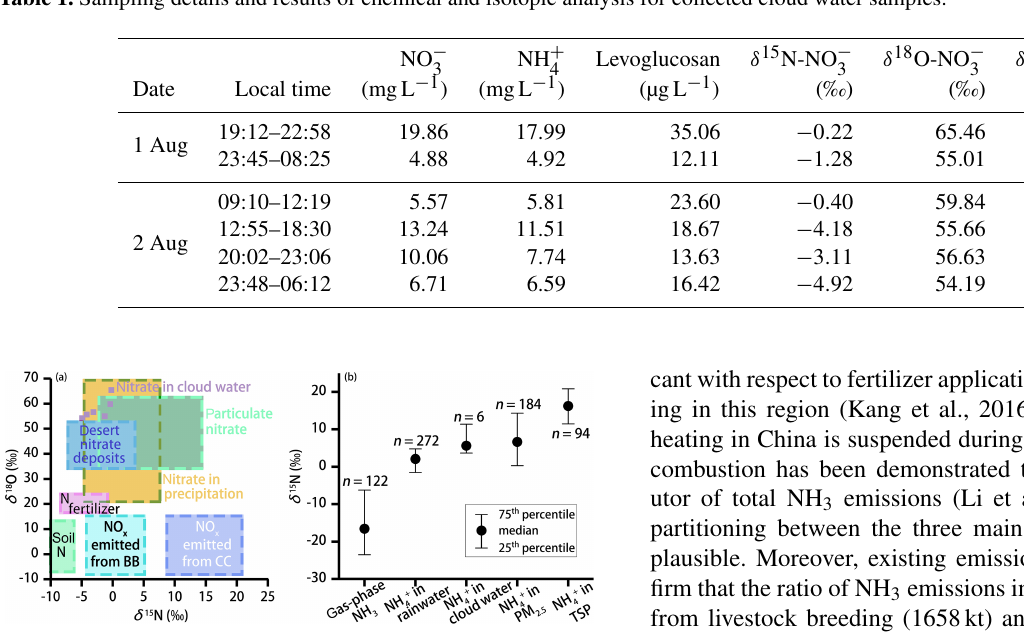
Table 1. Sampling details and results of chemical and isotopic analysis for collected cloud water samples.